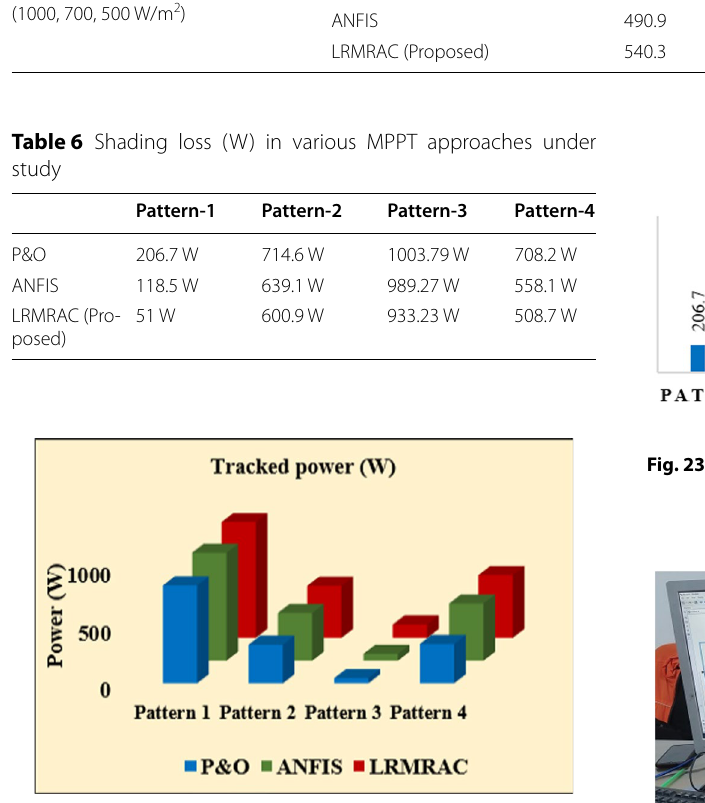
Fig. 22 Comparative analysis of tracked power